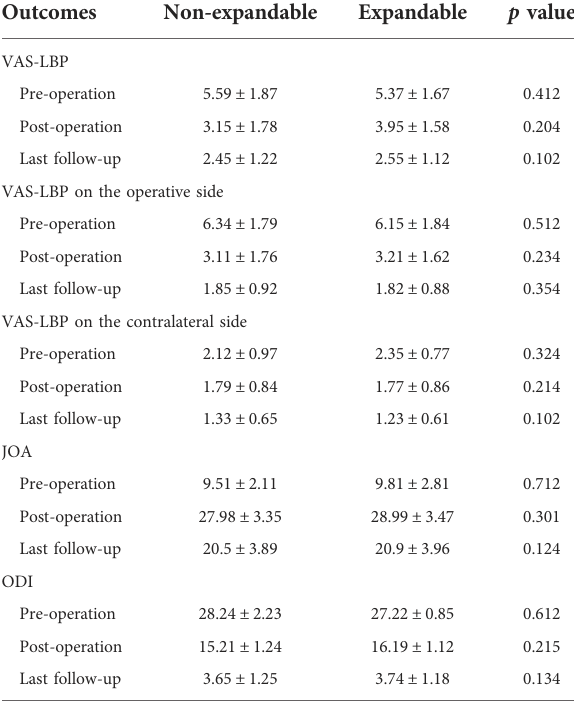
TABLE 3 Comparison of the clinical ef fi cacy at pre-operation, post- operation and last follow-up between patients instrumented with EXP-IFC and NE-IFC.